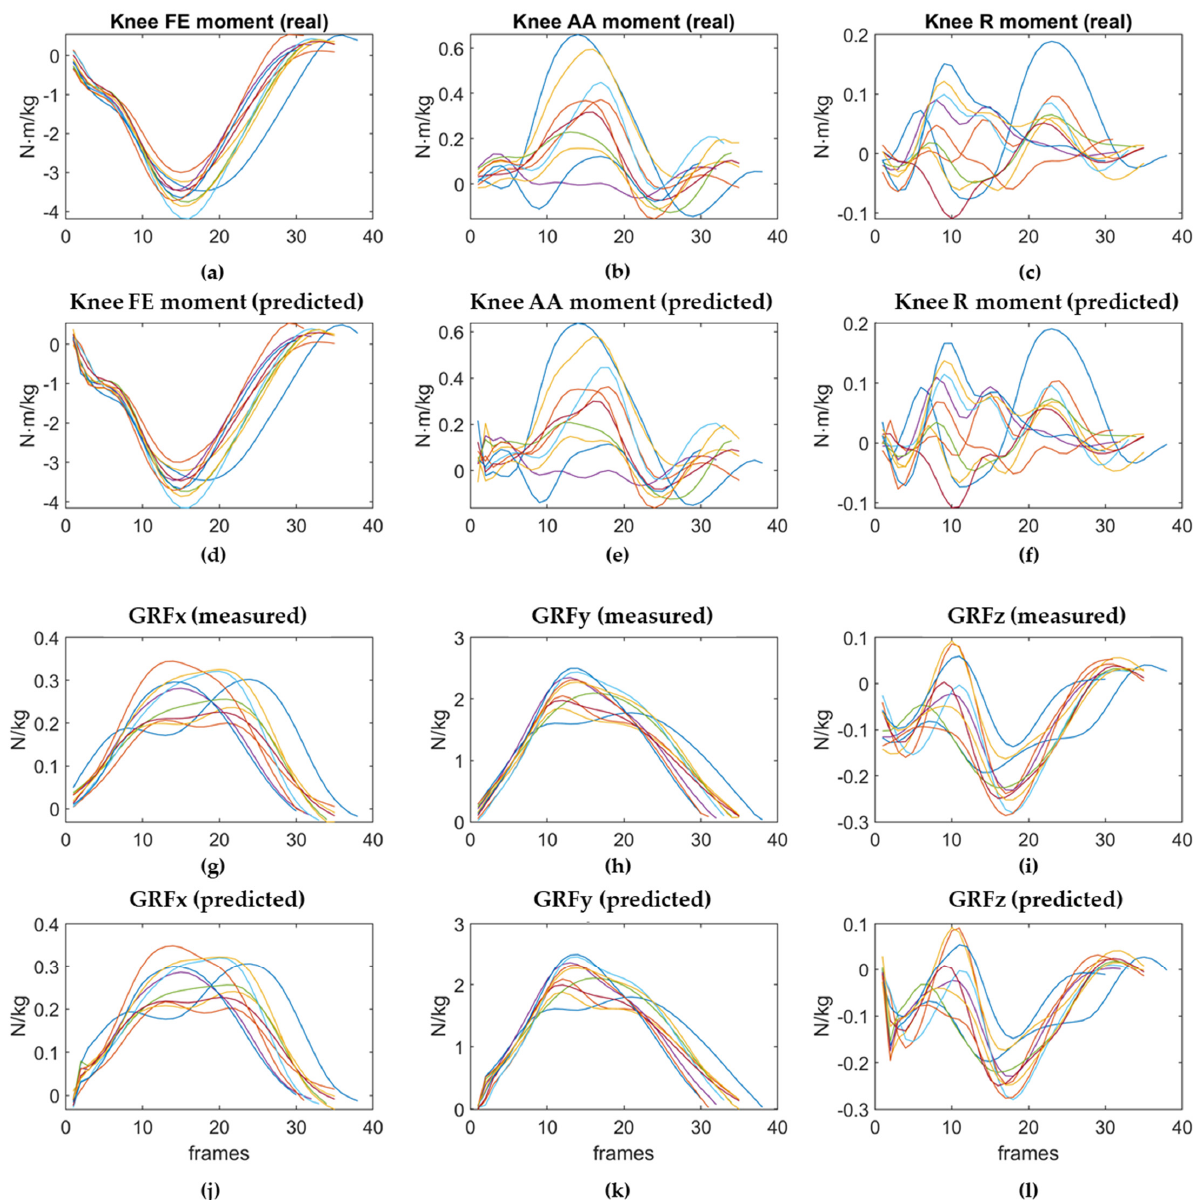
Figure 10. Real and predicted kinetic curves of subject 8. The predicted variables are the the Flexion/Extension (FE) mo ‐ ment, the Adduction/Abduction (AA) moment, and the Rotation (R) moment at the right knee joint, and the 3D GRFs. The predicted curves followed nearly the same pattern as the real curves, except at the very first contact with the ground, corresponding to the first frames of each landing phase of the VDJs. The mean RMSE values achieved for the prediction of GRFs and right knee moments by the developed neural network are reported in Table 4.